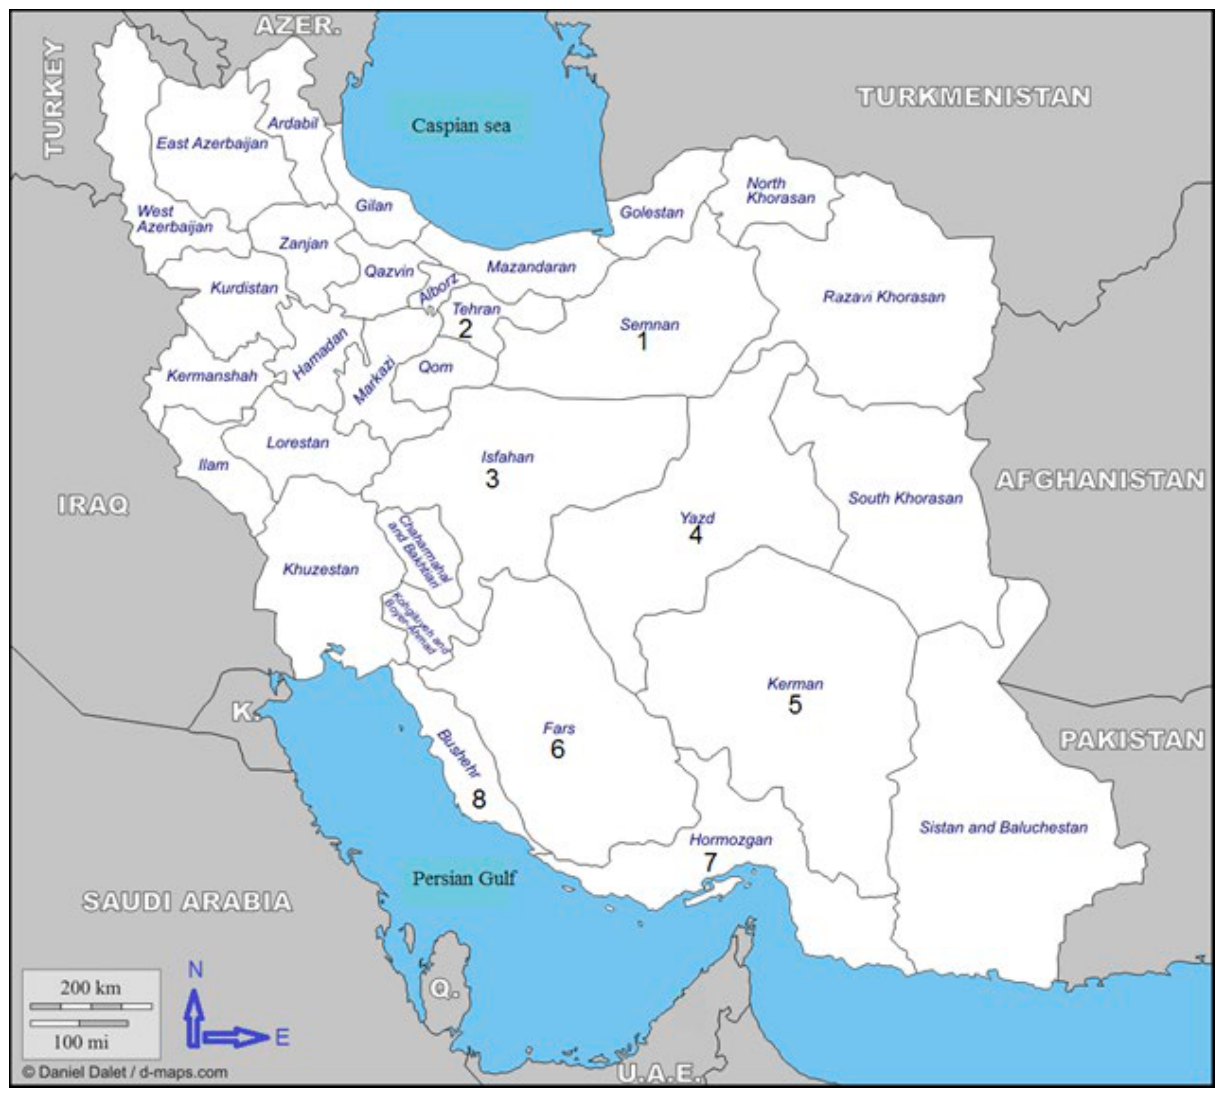
Figure 2. Map showing the provinces in Iran that were surveyed for Cucumber vein yellowing virus during 2011‒2012: 1, Semnan; 2, Tehran; 3, Isfahan; 4, Yazd; 5, Kerman; 6, Fars, 7; Hormozgan; and 8,